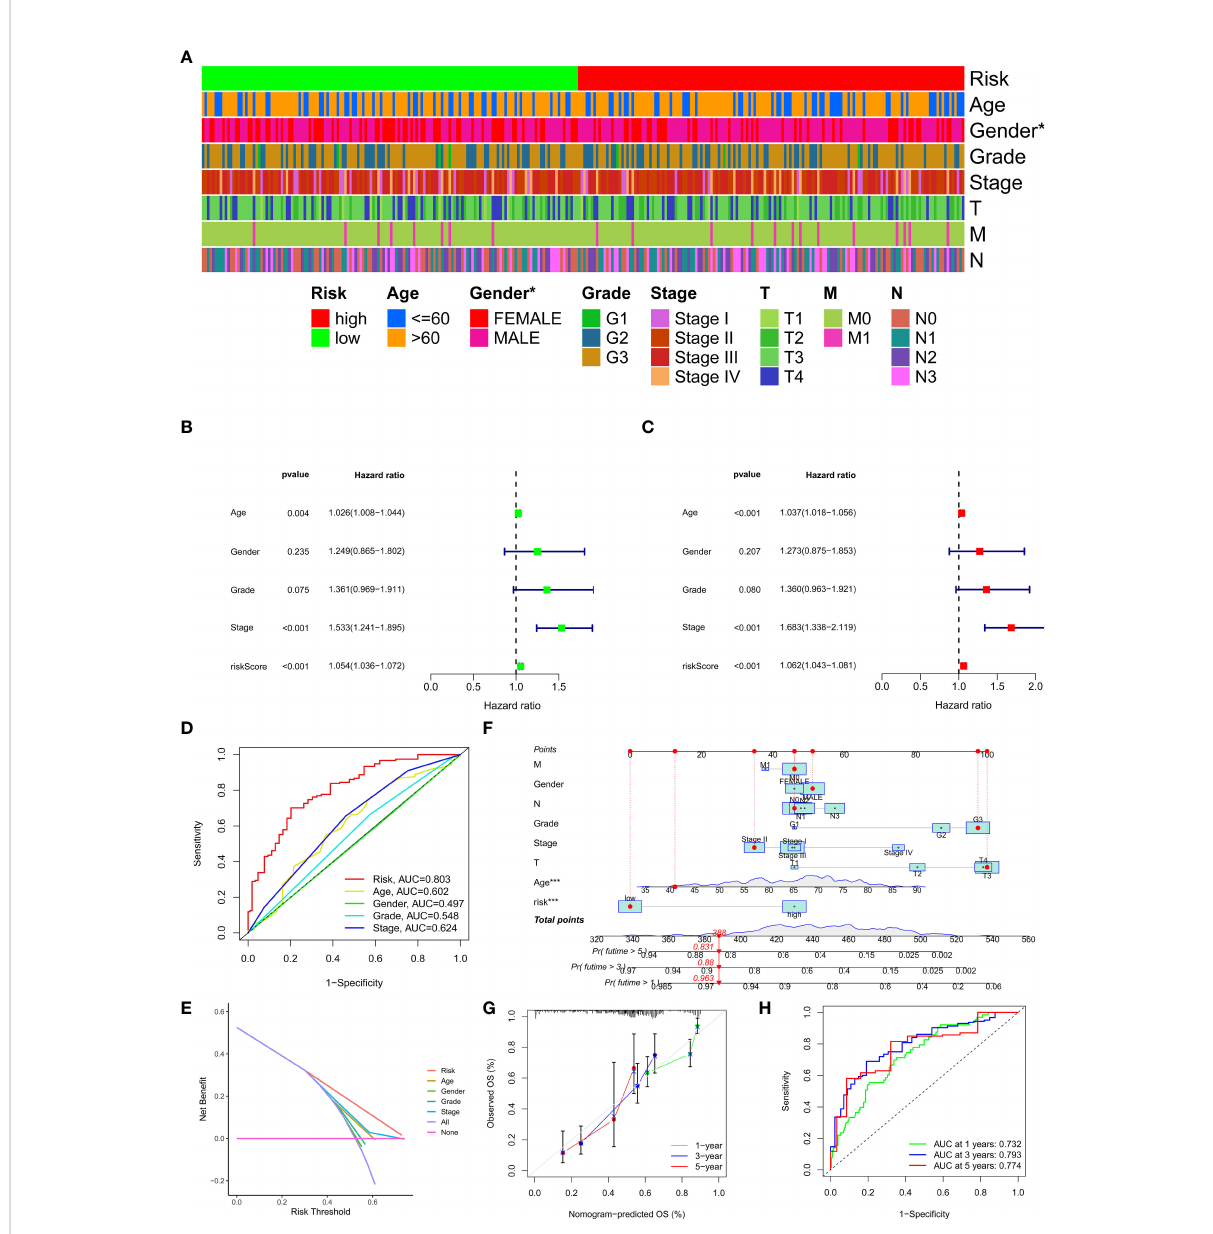
FIGURE 4 Clinical application of the risk model. (A) Correlation between the risk model and the clinicopathological characteristics of GC patients. (B, C) Univariate analysis and multivariate analysis were conducted to con fi rm the independent prognosis function of the model. (D, E) ROC, and DCA curves were performed to con fi rm the superiority of the risk score in clinical application. (F) The nomogram was plotted to obtain the predicting survival time of GC patients. (G) A calibration curve was applied to assess the accuracy of the model in predicting patients ’ survival time. (H) The AUC value of the nomogram. *p < 0.05, and ***p <